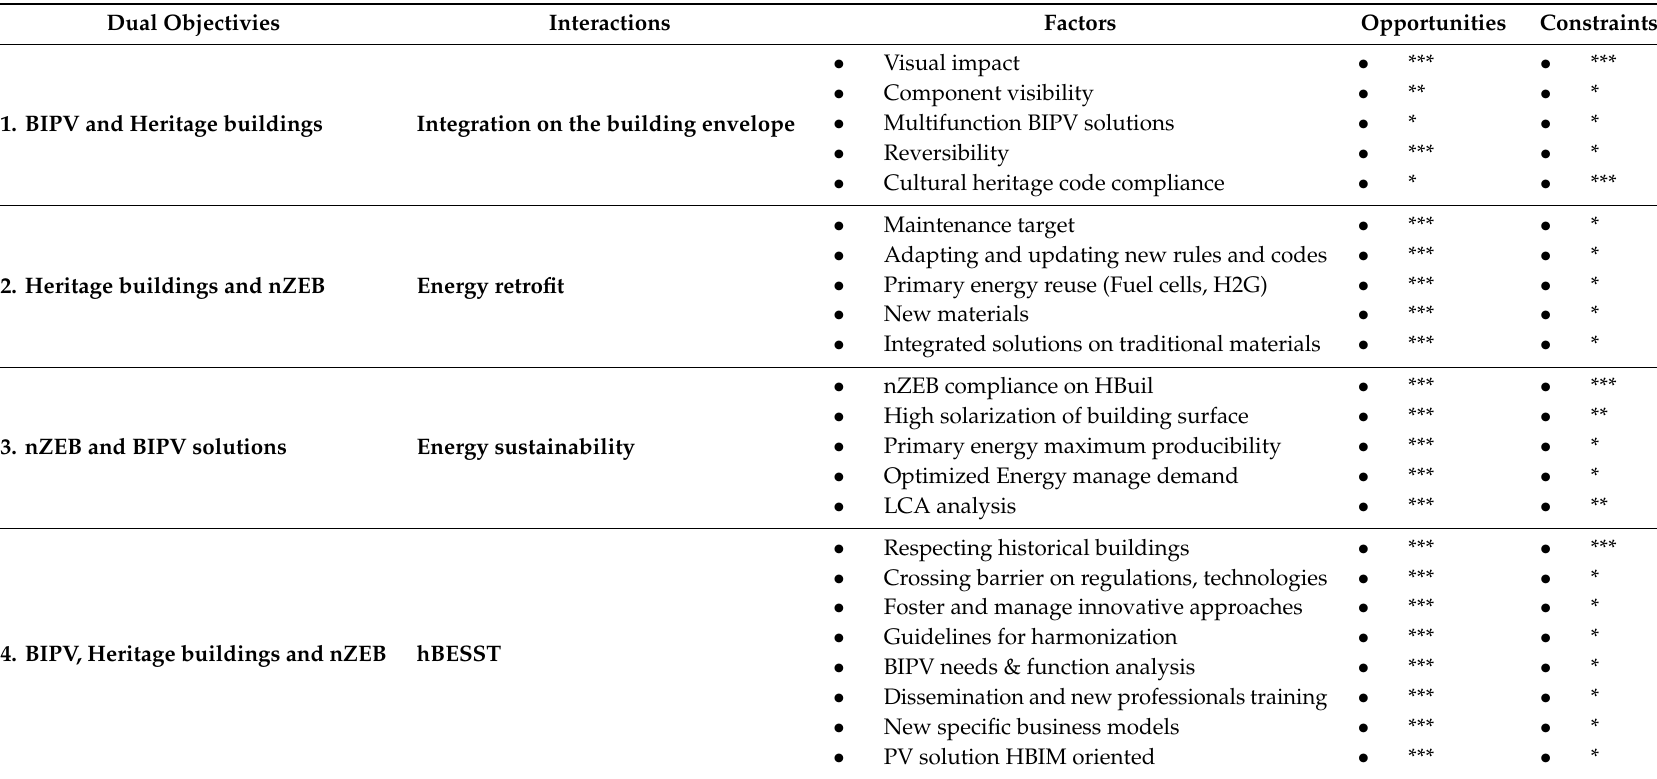
Table 8. Opportunities and constraints assessment according to the factors determined by the